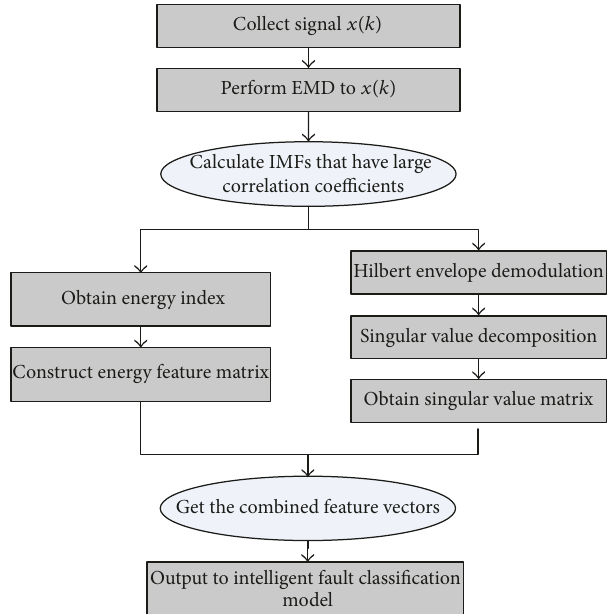
Figure 3: Flow chart of the extraction of fault feature